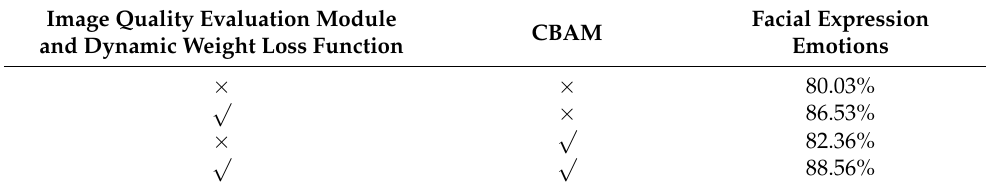
Table 4. Ablation experiment on the Facial Expression Emotions dataset (in terms of